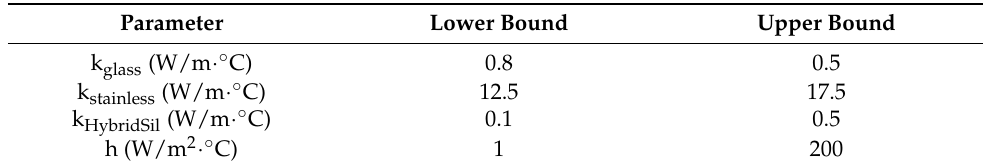
Table 2. Lower and upper bounds for the model calibration parameters.